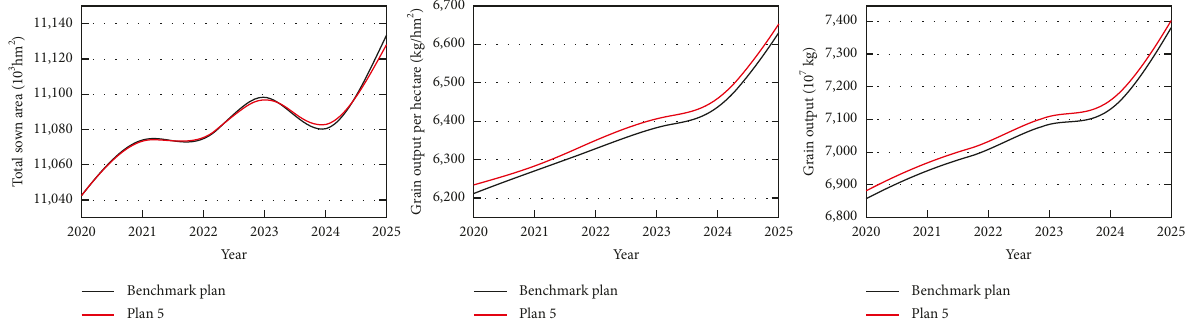
Figure 7: Comparison of simulation results between Benchmark plan and Plan 5.